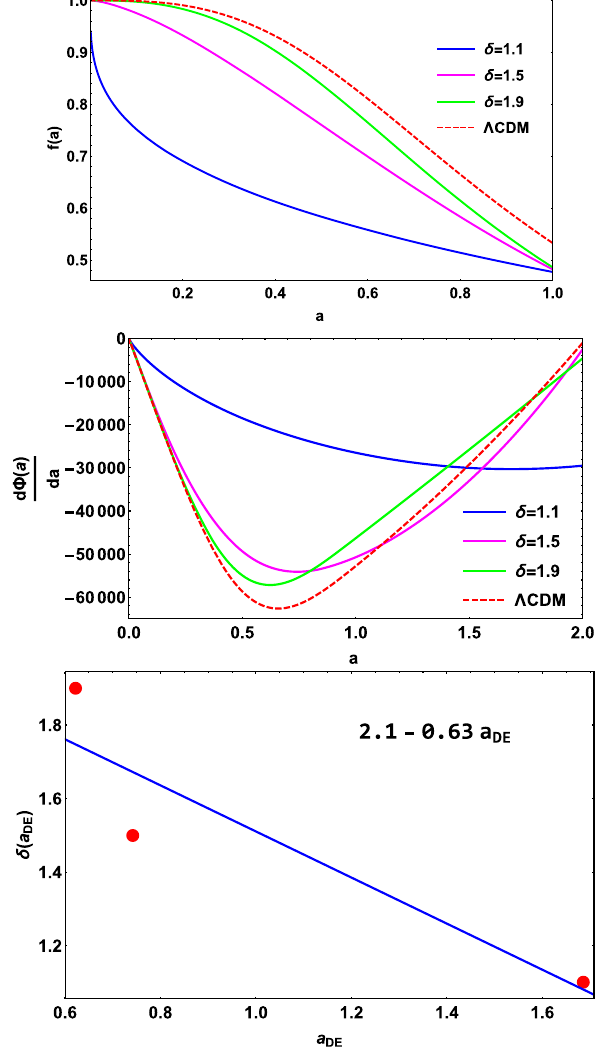
Fig. 1 Topleftpanelshowstheevolutionofgrowthrate f ( a ) ,topright panel shows the rate of change of configurational entropy ( d Φ( a ) the lower panel shows the best fit relation between the non-additivity parameter δ and the scale factor a DE at which d Φ( a )